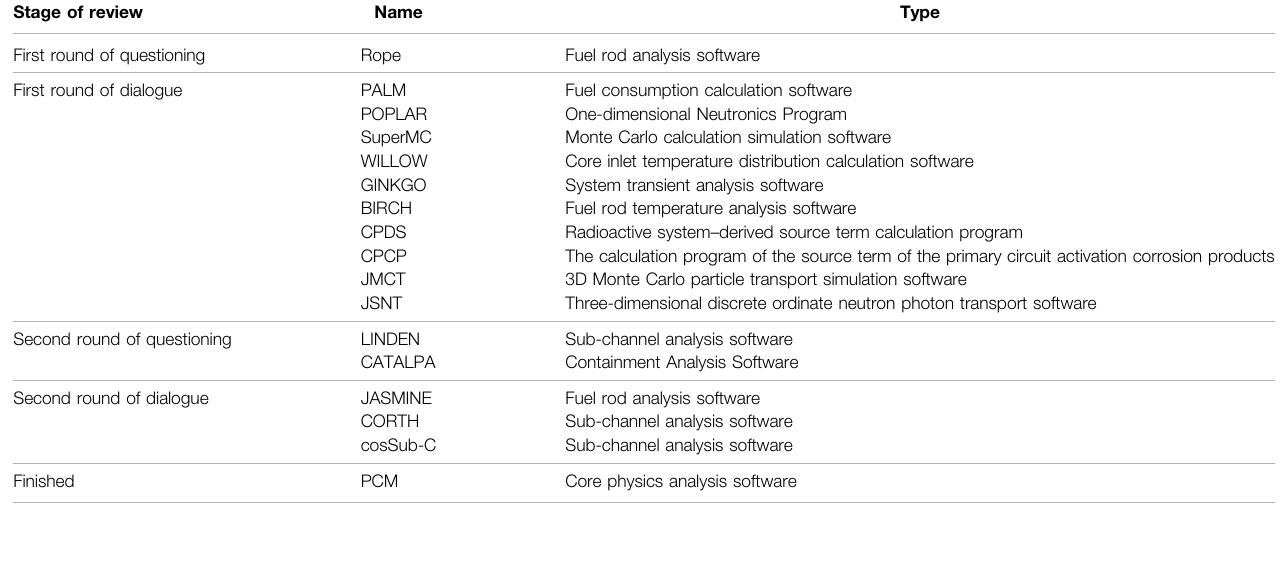
TABLE 1 | Software under review and the stage of the review.